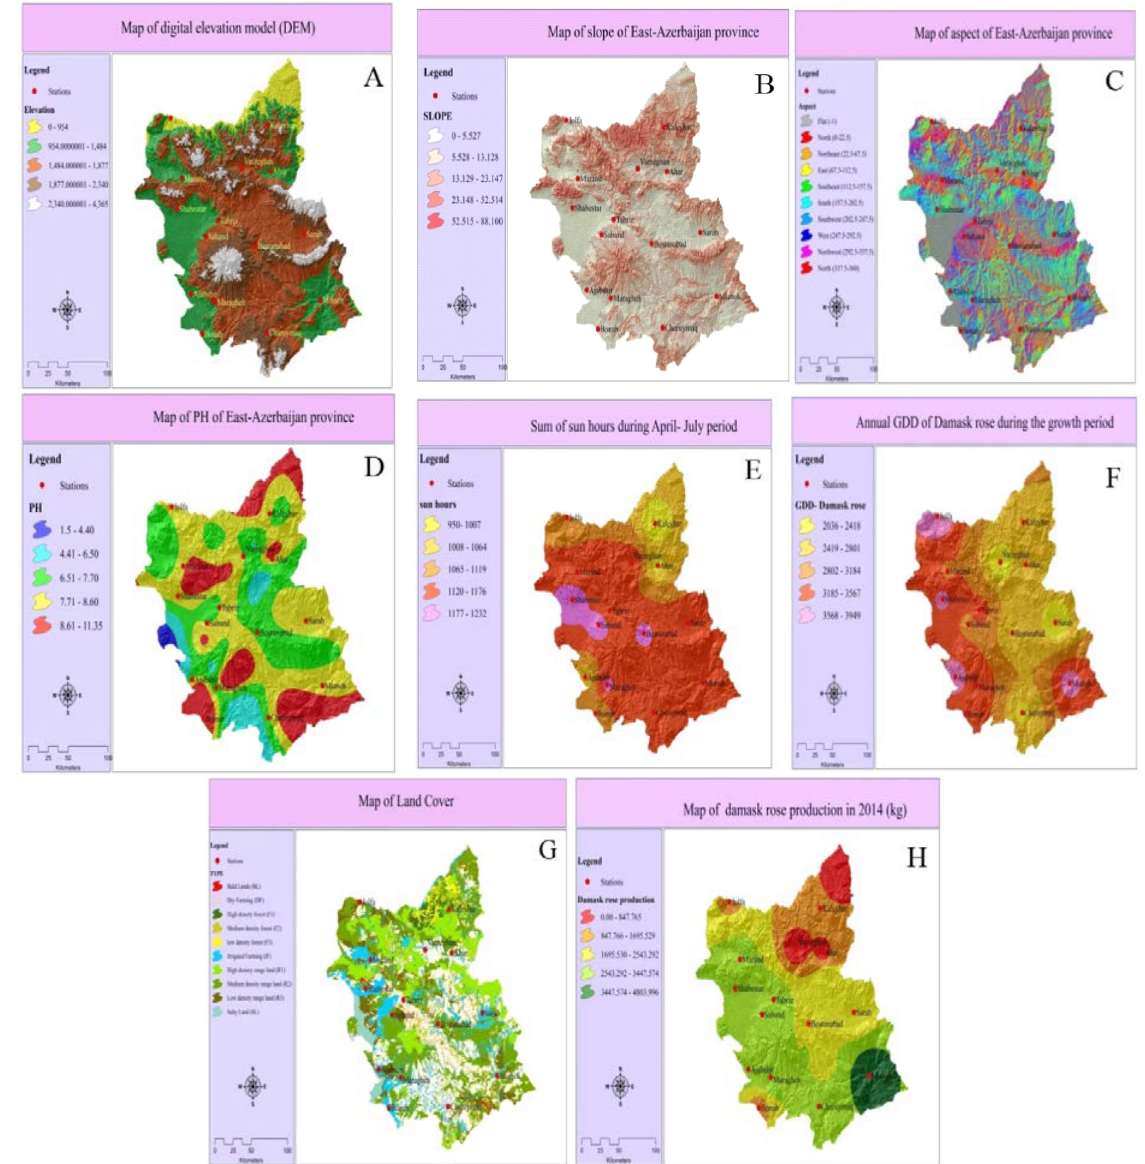
Fig. 4: Criteria spatial distributions of the study area: A) Map of digital elevation model of East-Azerbaijan B) Map of slope C) Map of aspect D) Map of soil pH in 2013 E) Map of sun hours during April-July period F) Map of growth degree days for Damask Rose plant G) Map of land cover of East-Azerbaijan H) Map of Damask Rose production in